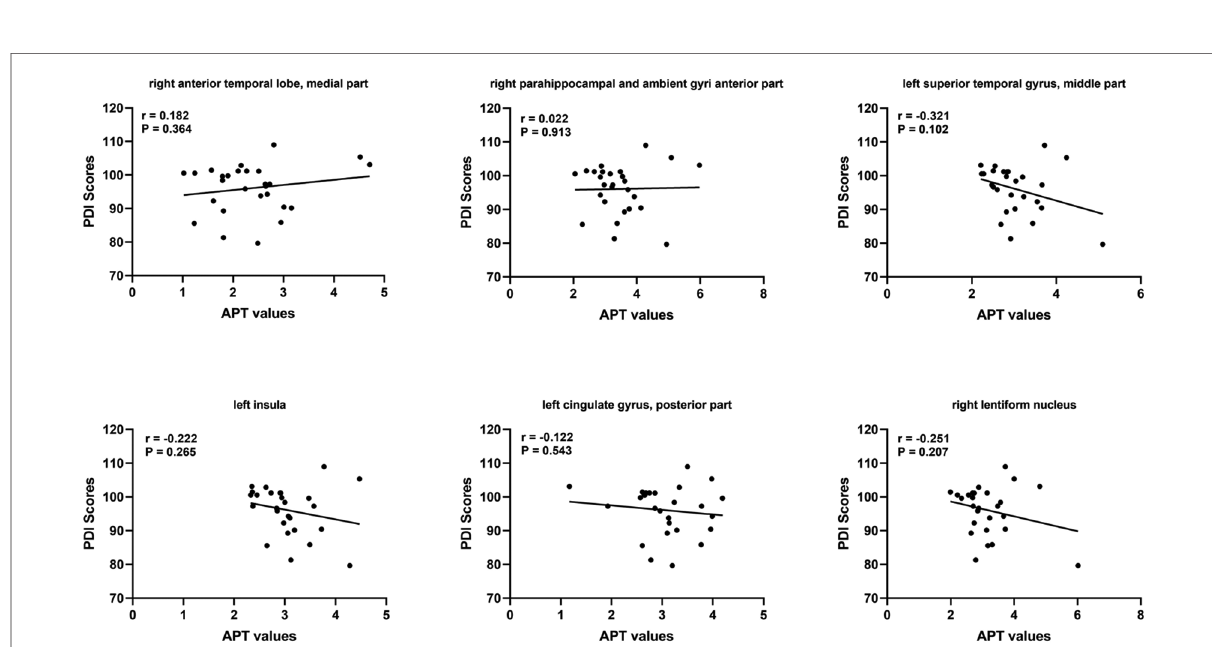
FIGURE 4 Relationship between PDI scores and region APT values in HIE/MRI+